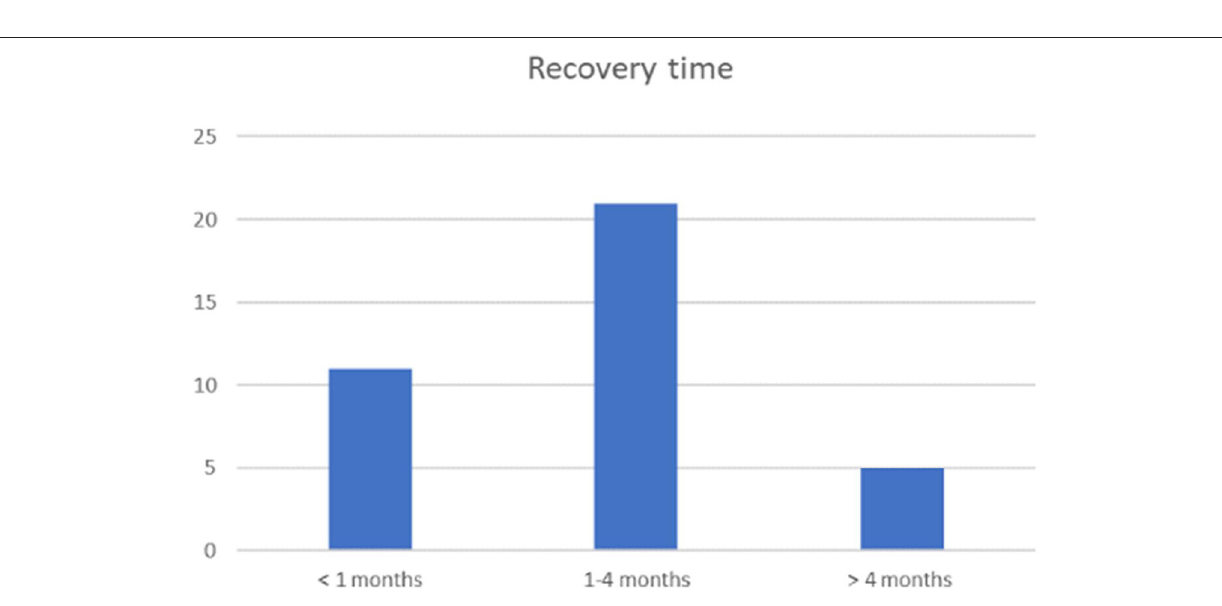
within 4 weeks, 56.8% (21/37) within 1–4 months, and in 13.5% (5/37) recovery took longer than 4 months. A younger age at the was statistically significant associated with recovery ( p <